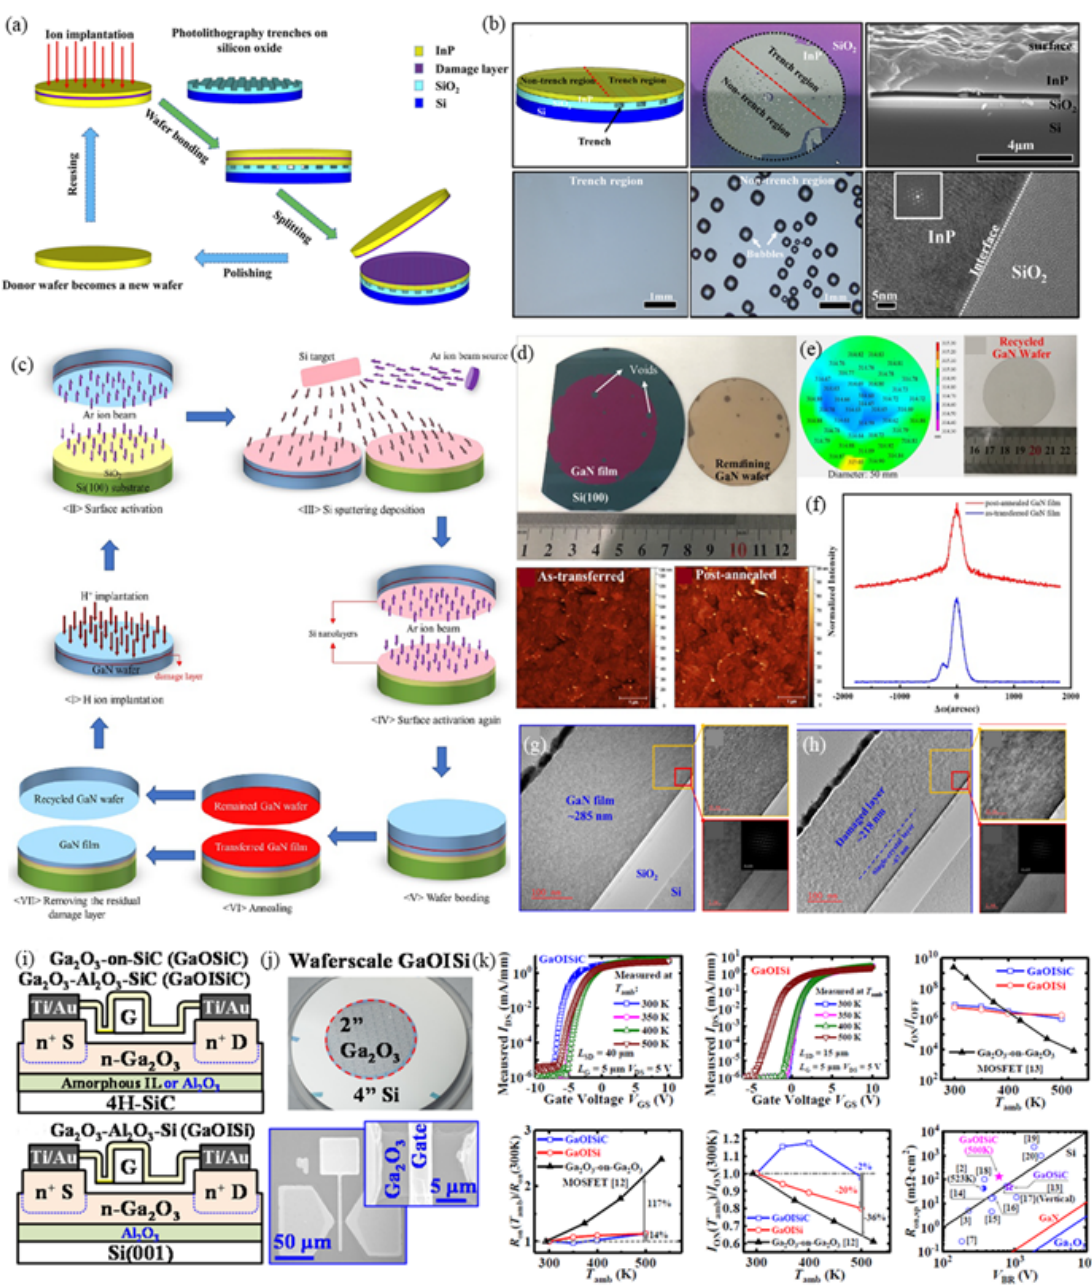
Figure 3. Heterogeneous bonding for III-V and wide bandgap semiconductor thin-film transfer onto Si substrate and their applications. ( a ) Schematic diagram of the modified Smart Cut TM technology for InP thin-film transfer [88]. ( b ) Optical and SEM images for the transferred InP thin film onto Si substrate [88]. ( c ) Schematic diagram of the modified Smart Cut TM technology for GaN thin-film transfer [89]. ( d ) Optical image of the transferred GaN thin film onto Si substrate [89]. ( e ) Thickness and AFM measurements for the transferred GaN thin film [89]. ( f ) XRD characterization for the GaN thin film before and after the annealing treatment [89]. ( g , h ) TEM observation for the bonding interface before and after the annealing treatment [89]. ( i ) Schematic diagram of the Ga 2 O 3 -based MOSFET [90]. ( j ) Optical image of the transferred wafer-level GaOISi and SEM image of the device structure [90]. ( k ) Performance characterizations of the Ga 2 O 3 -based MOSFET [90]. Reprinted with permission from ref. [88]. Copyright 2020 American Institute of Physics. Reprinted